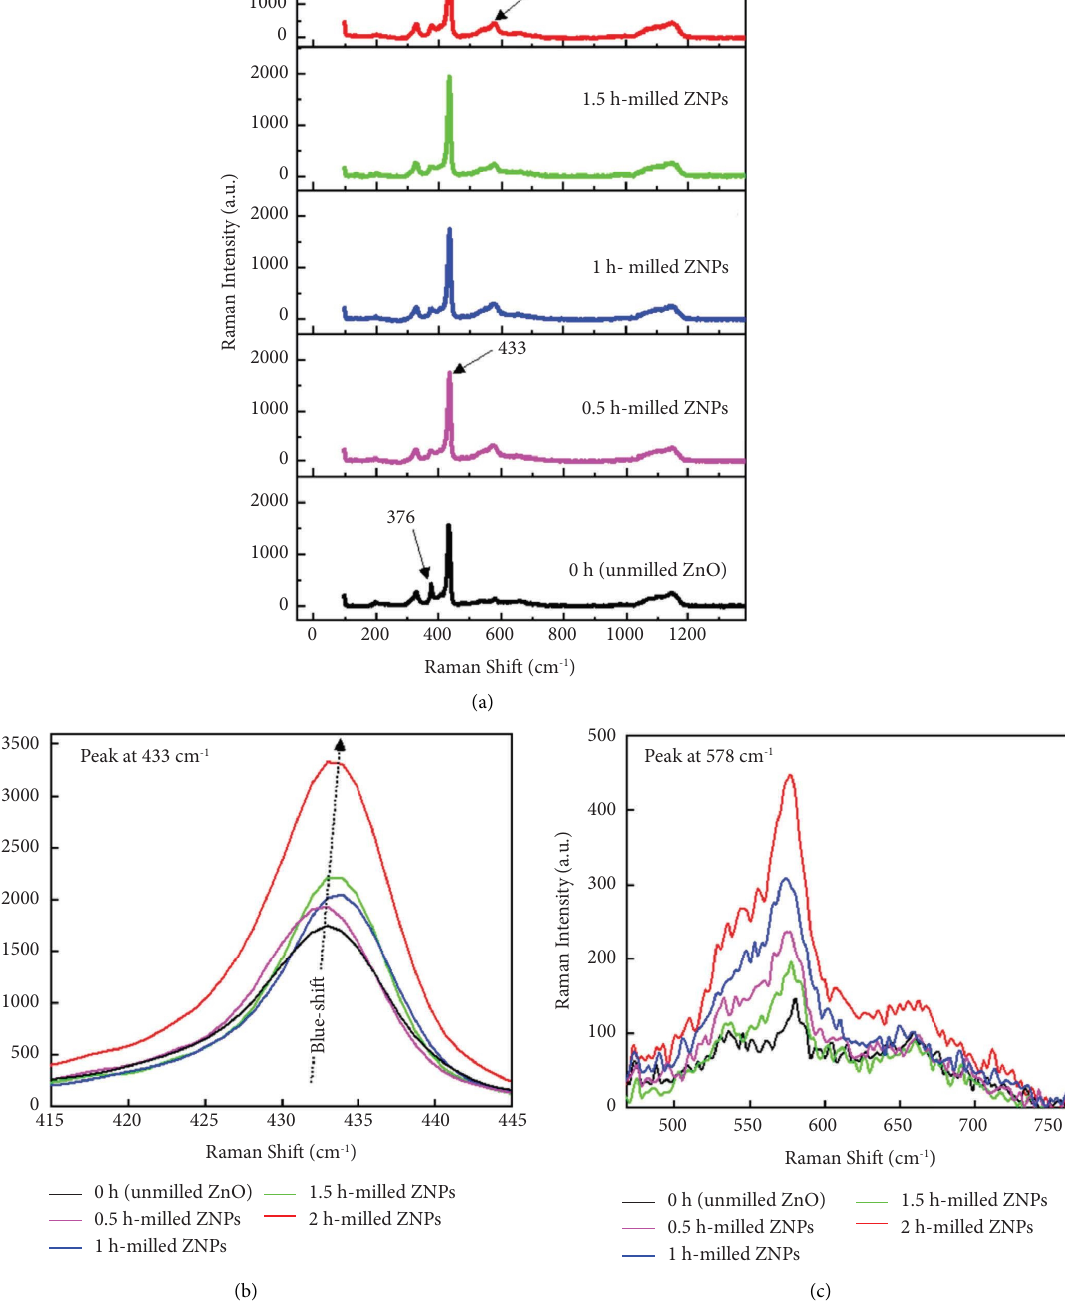
Figure 6: (a) Raman scattering spectra in the frequency domain 100–3500cm − 1 of milled ZNPs during 0.5, 1, 1.5, and 2 h. Note that the spectrum at 0 h corresponds to the unmilled ZnO powder. Zoom of 415–445cm − 1 (b) and 450–750cm − 1 (c) frequency most inhibited by the milled ZNPs. Followed by the E. coli Table 3. ZNPs milled under these conditions have broad- ATCC 25922 which was inhibited only when the ZNPs were spectrum activity against Gram-negative/Gram-positive milled for 1.5 and 2 h, while E. coli, K. pneumonia , and bacteria and candida. Tis inhibition is, however, de- P. aeruginosa were resistant to all milled and unmilled pendent on both nanoparticle size and microorganism type. samples, in Gram-positive bacteria, both S. aureus and In Gram-negative bacteria, the bacterium S. sonnei was the